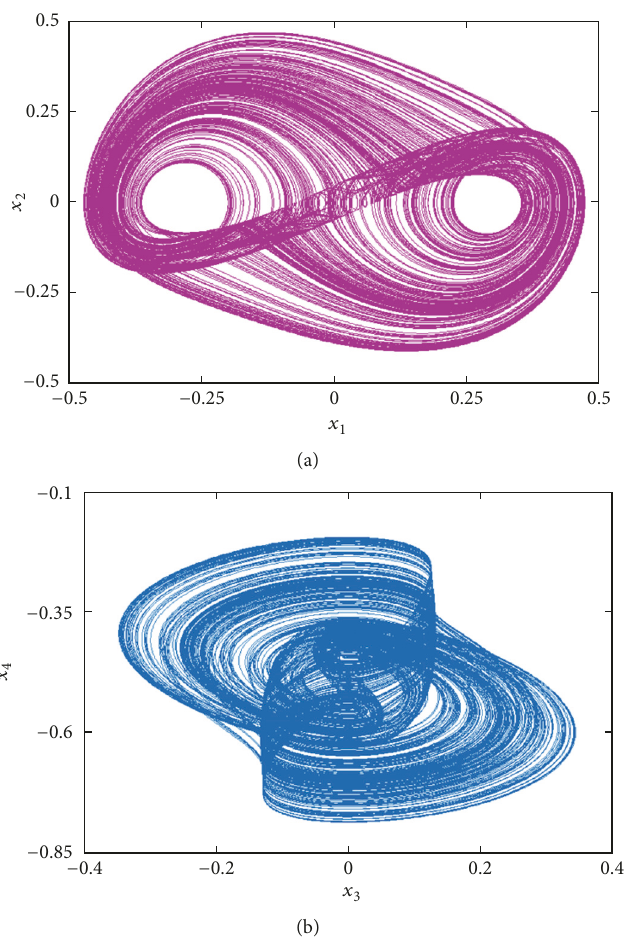
Figure 1: Double-scroll chaotic attractor generated by the memristive jerk system with 𝑎 = 0.7 , 𝑏 = 10 , 𝑥 1 (0) = 0 , 𝑥 2 (0) = 10 −6 , 𝑥 3 (0) = 0 , and 𝑥 4 (0) = −0.5 . (a) Phase portrait in the x 1 ( t ) − x 2 ( t ) plane. (b) Phase portrait in the x 3 ( t ) − x 4 ( t ) plane.